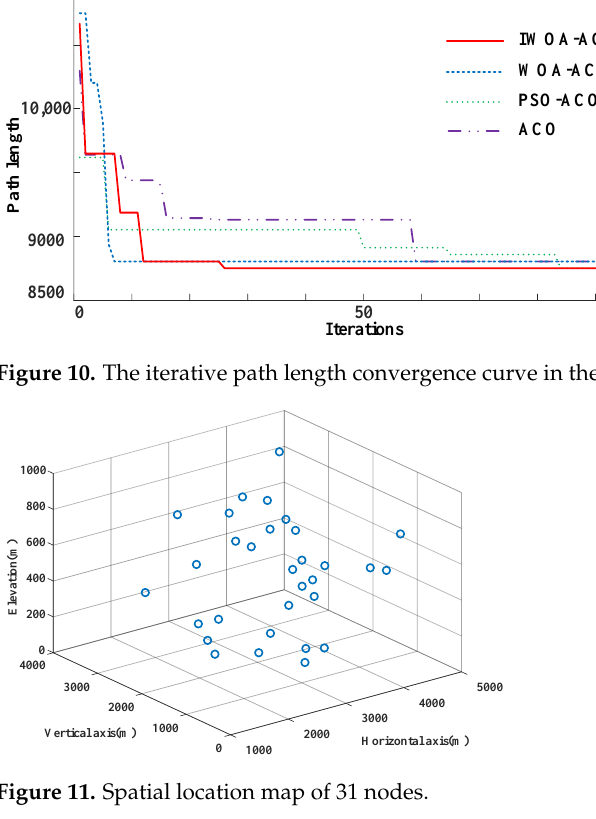
IWOA-ACO WOA-ACO PSO-ACO Iterations Figure 12. The convergence curve of the evaluation function in the simulation of bump environment.